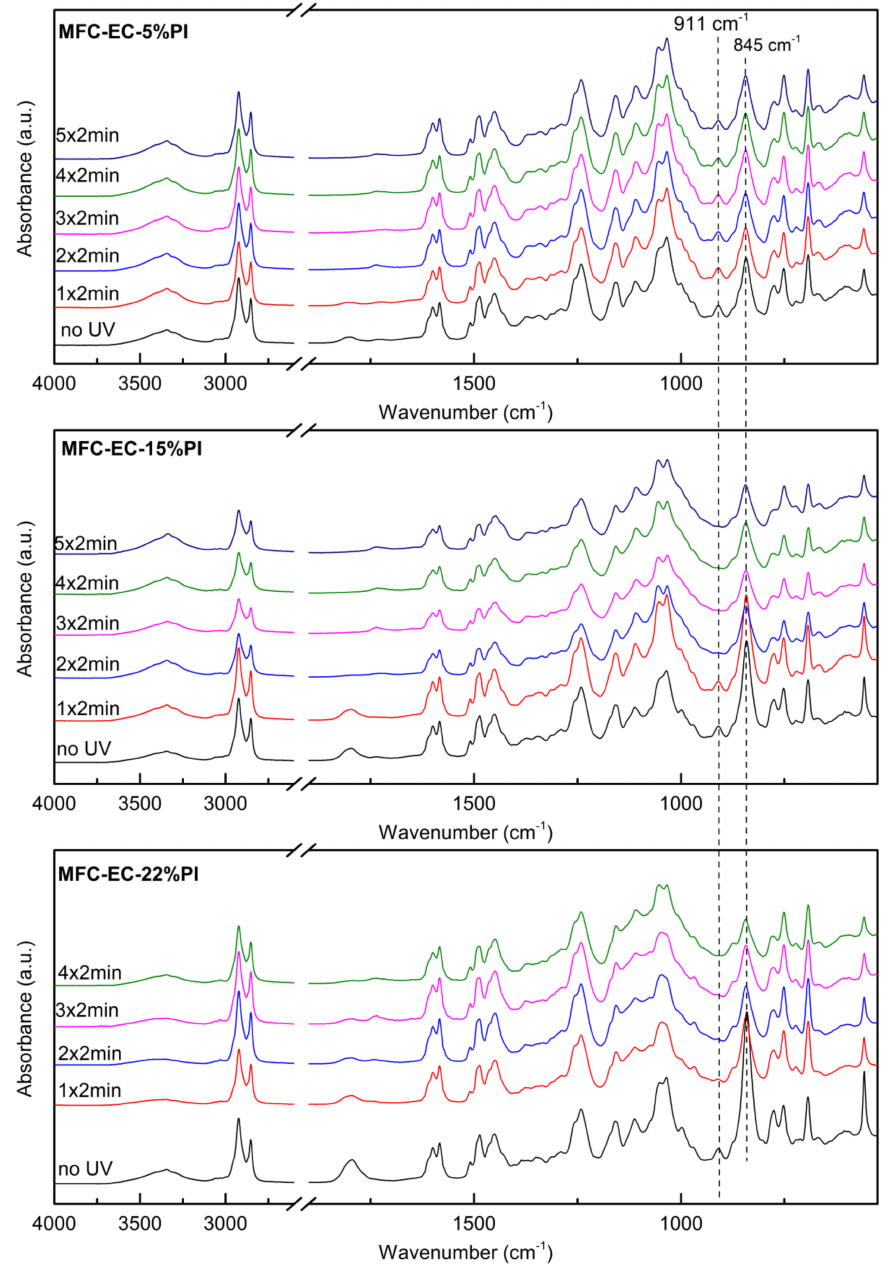
Figure 8. ATR FT-IR spectra composites MFC-EC-5%PI, MFC-EC-15%PI and MFC-EC-22%PI with di ff erent times of UV irradiation at 100 mW cm − 2 (“n × 2 min” indicates that irradiation was carried out for n minutes on each